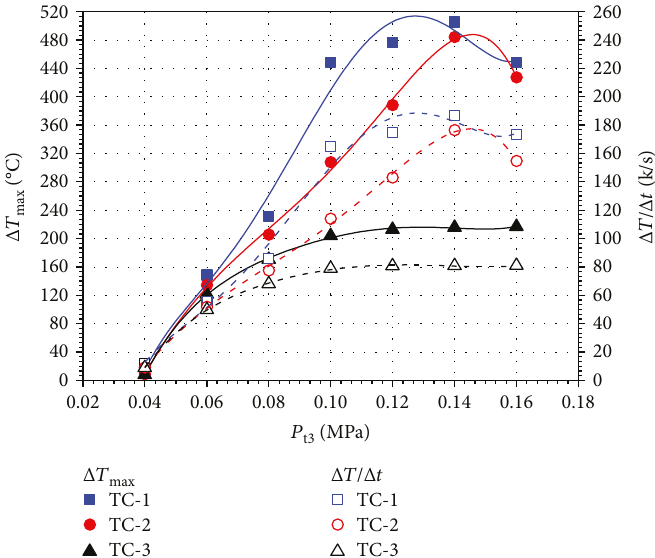
Figure 8: E ff ect of inlet pressure on the maximum temperature rise and maximum rate of temperature rise at the combustion chamber